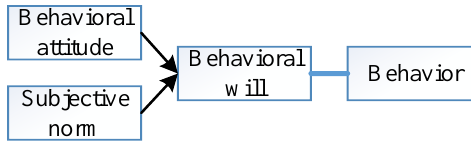
Figure 2. Rational Behavior Theory Model.